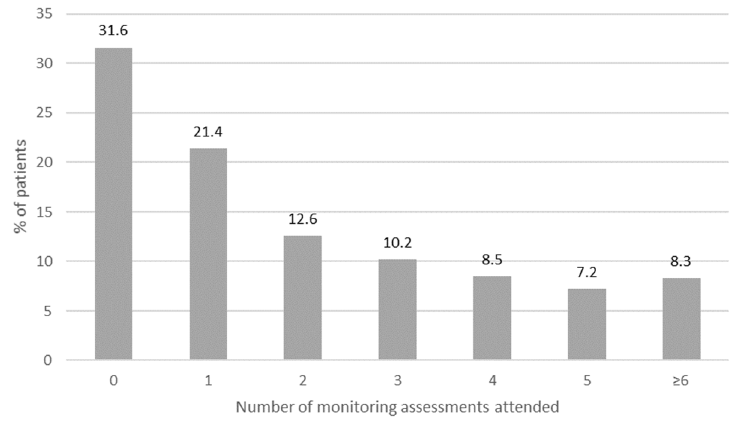
Figure 3. Distribution of the number of monitoring assessments attended by patients ( n = 831).